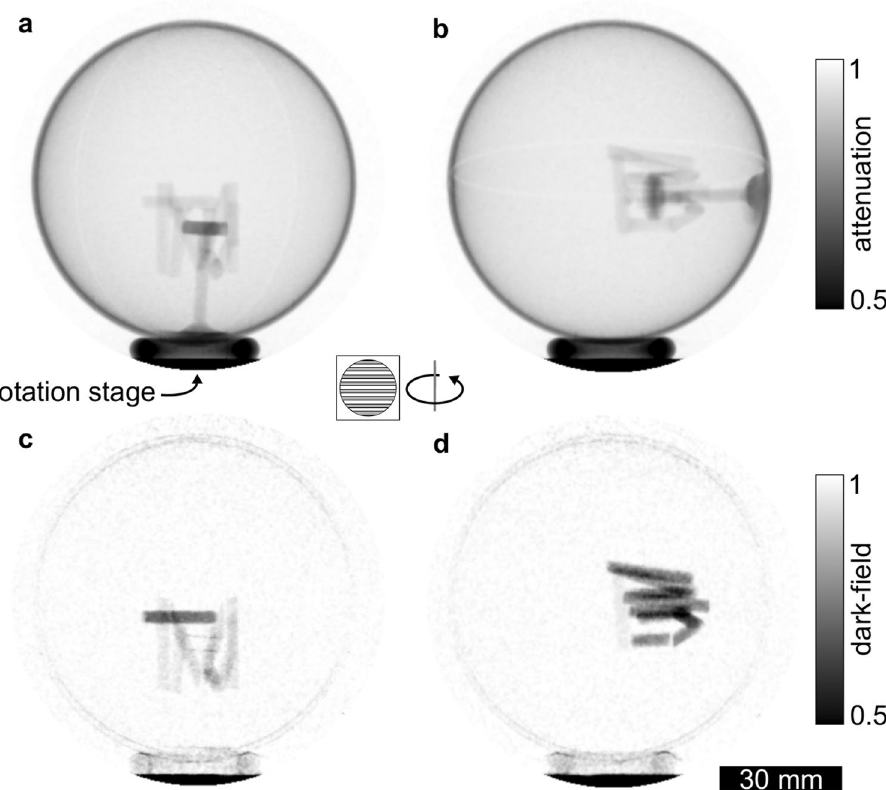
Figure 3. Sample rotation during the measurement. In order to allow for an arbitrary sample positioning on top of the rotation axis, the sample was mounted inside a hollow sphere. This auxiliary sample mounting allows to position any axis through the sample parallel to the sensitivity direction of the gratings. Attenuation ( a ) and ( b ) as well as dark-field ( c ) and ( d ) projections are shown for two positions of the